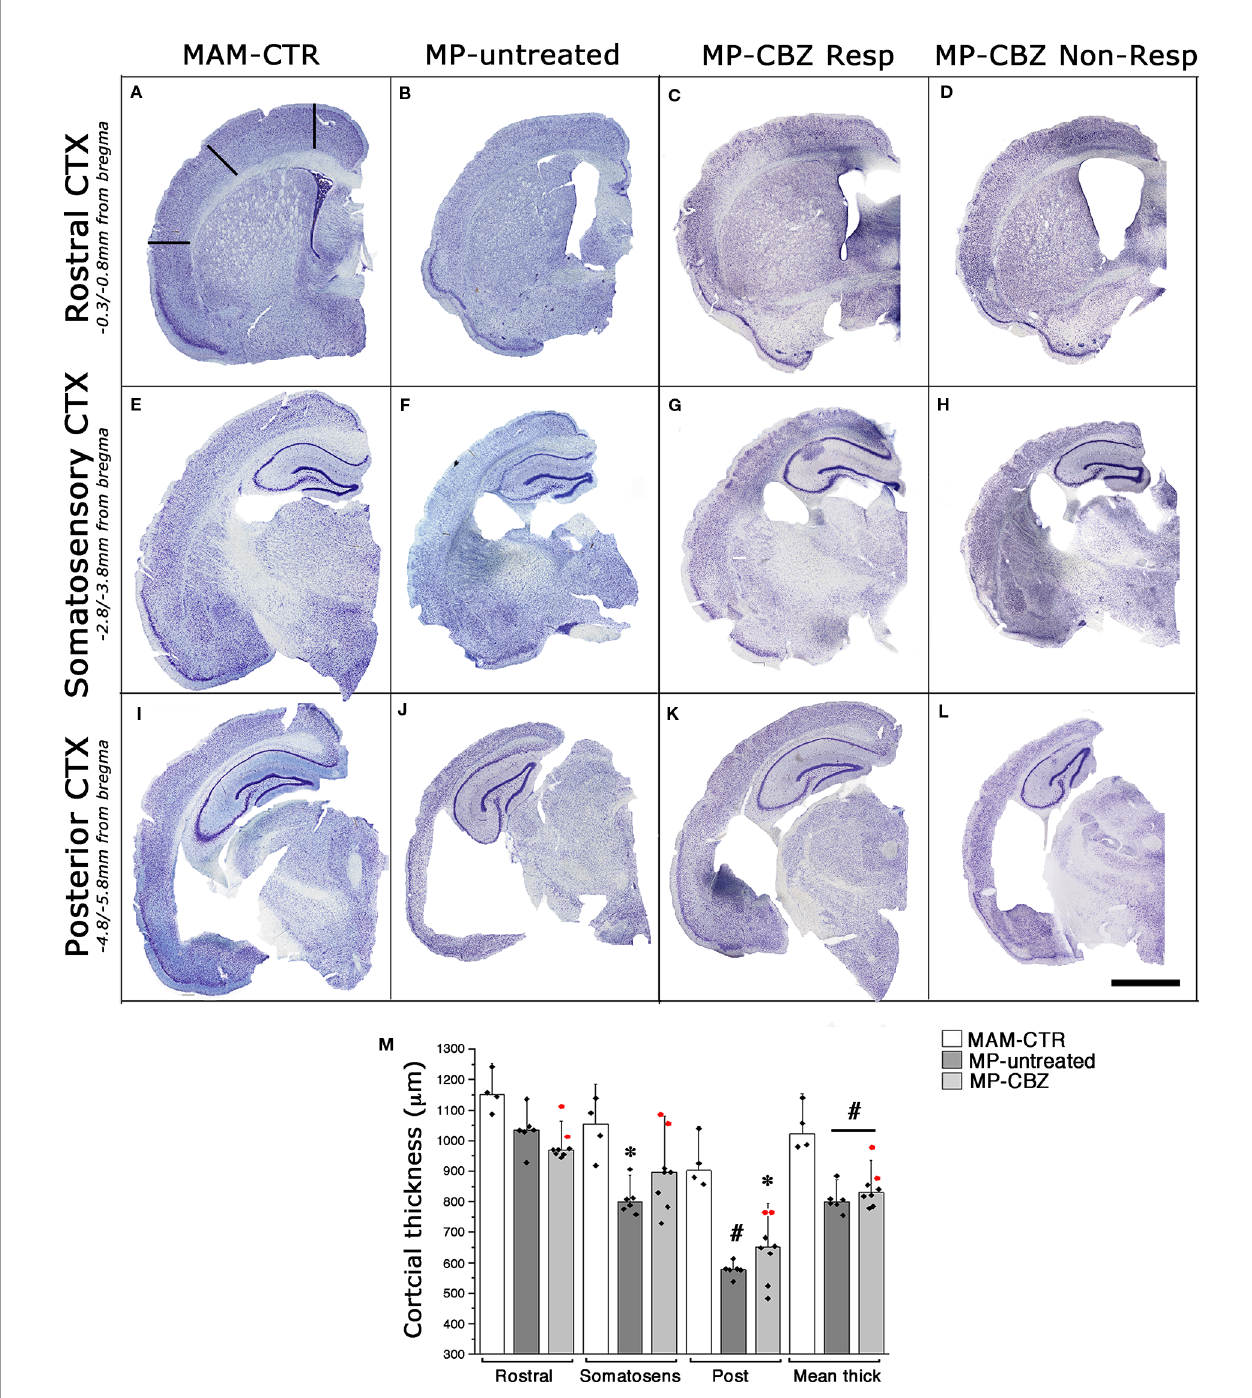
FIGURE 2 | Effects of seizures and CBZ treatment on neocortical atrophy. (A – L) Low-power thionine-stained coronal sections from rostral (A – D) , somatosensory (E – H) and posterior (I – L) cortical areas in representative non-epileptic naïve MAM (MAM-CTR; A, E, I) , epileptic MP-untreated (B, F, J) , MP-CBZ/responder (C, G, K) and MP-CBZ/non responder rats (D, H, L) . Scale-bar: 2mm (M) Bar-chart with dot-plots of single measurements of cortical thickness analyzed in different cortical region in MAM-CTR (n = 4), MP-untreated (n = 6) and MP-CBZ rat (n = 8) groups. Cortical thickness was signi fi cantly affected in the posterior cortex (Post) in both MP-untreated ( # p < 0.01) and MP-CBZ (* p < 0.05) vs MAM-CTR rats. Mean cortical thickness (Mean thick) was signi fi cantly decreased in both MP-untreated and MP-CBZ rats when compared to MAM-CTR rats ( # p < 0.01). A trend to decrease, although not signi fi cant, was observed in the rostral and somatosensory cortical areas in MP-CBZ vs MAM-CTR. Differences never emerged by comparing MP-CBZ with MP-untreated rats. Red-dots indicate the single cortical measurements of the 2 rats in which CBZ treatment totally affected convulsive stage 4 – 7 seizures. Data were expressed as mean ±